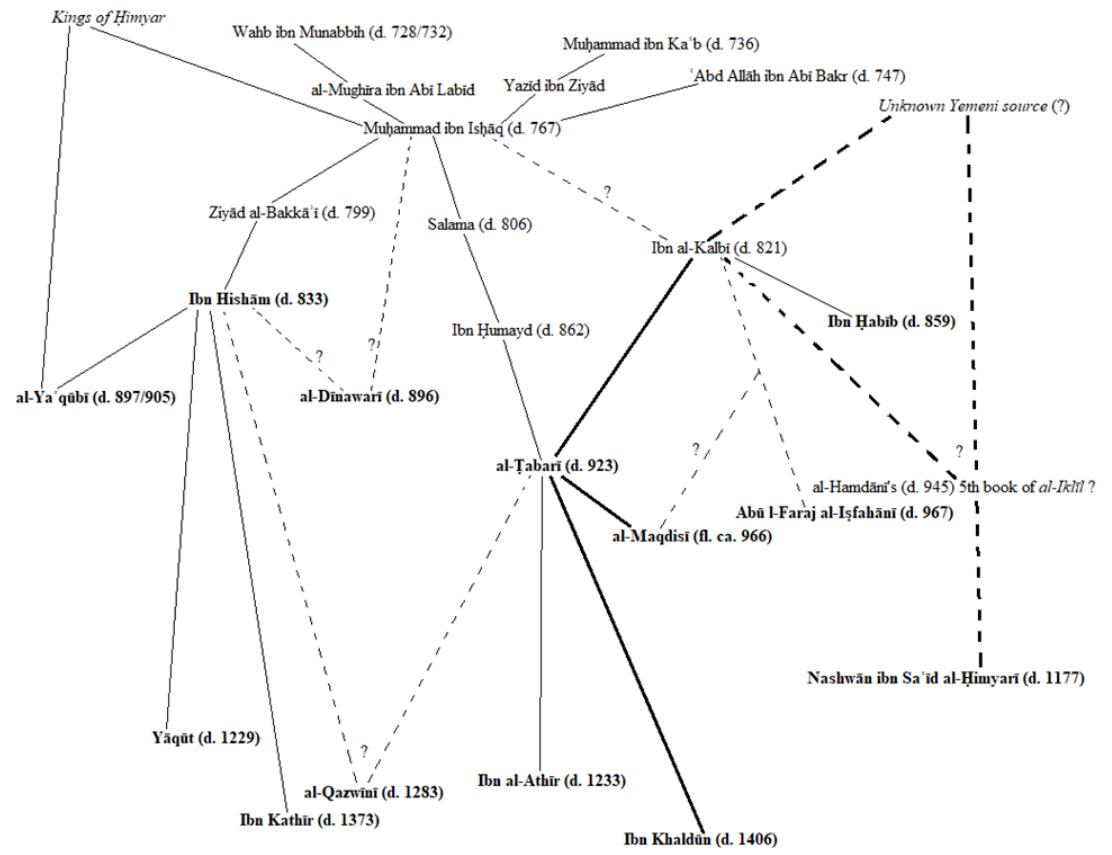
Figure 3 The tradition of Ibn Isḥāq/Ibn